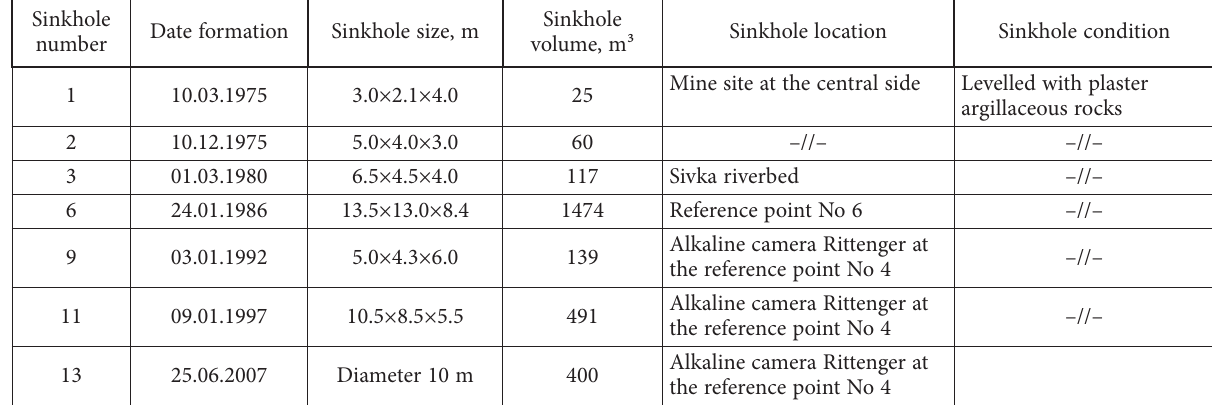
Table 2. Sinkholes’ characteristic have collected at the Central kainite ore